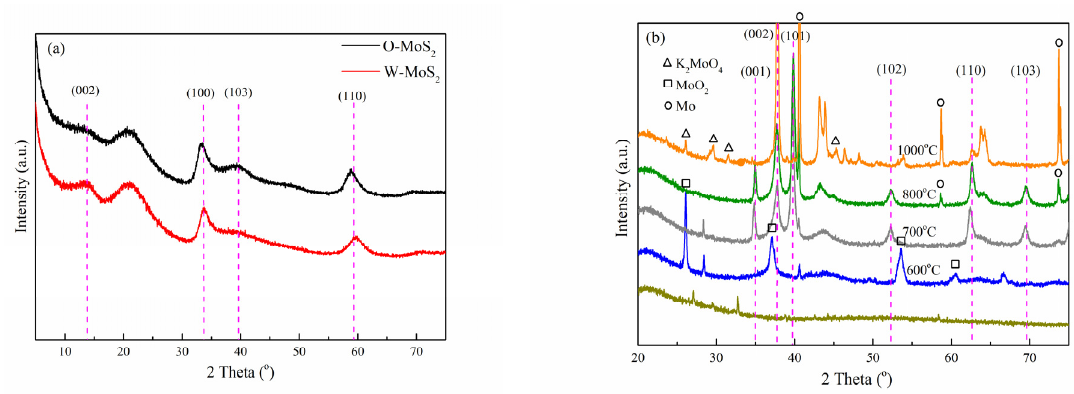
Figure 2. XRD patterns of catalysts, ( a ) MoS 2 , and ( b ) Mo 2